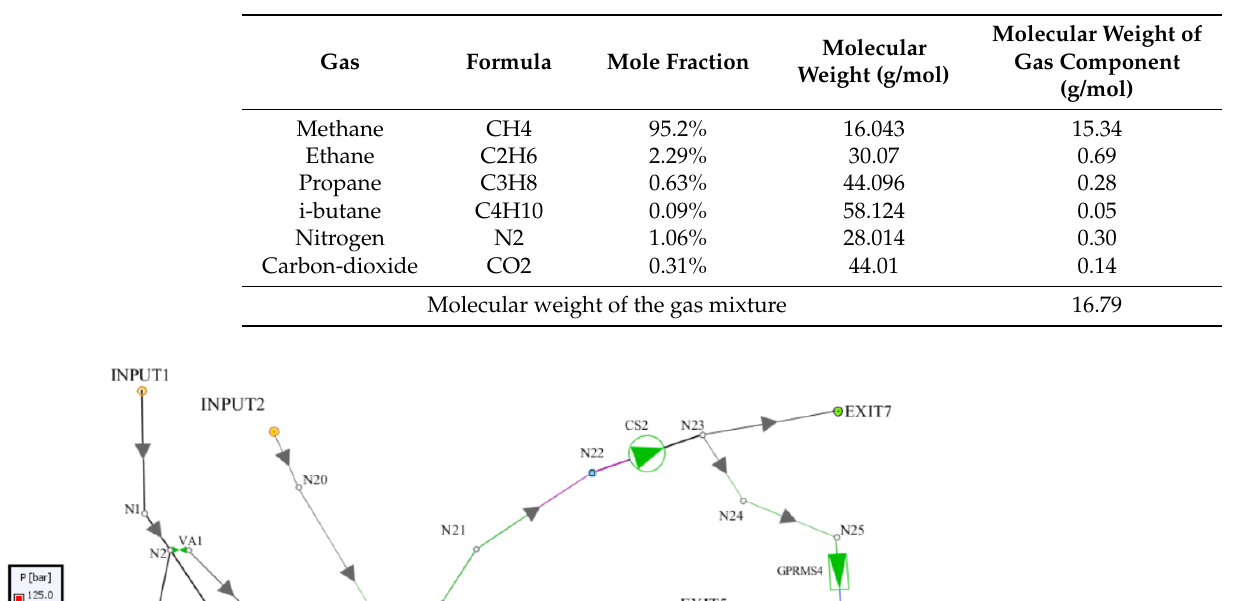
in Figure 2. Two valves VA1 and VA2 served to switch off the pipelines N2–N7 and N7–N8 out of operation in situations when the gas flow velocities through them fell below the critical value. In those situations, all downstream natural gas flows through the pipeline N2–N8. Table 1. Composition of the processed natural gas.